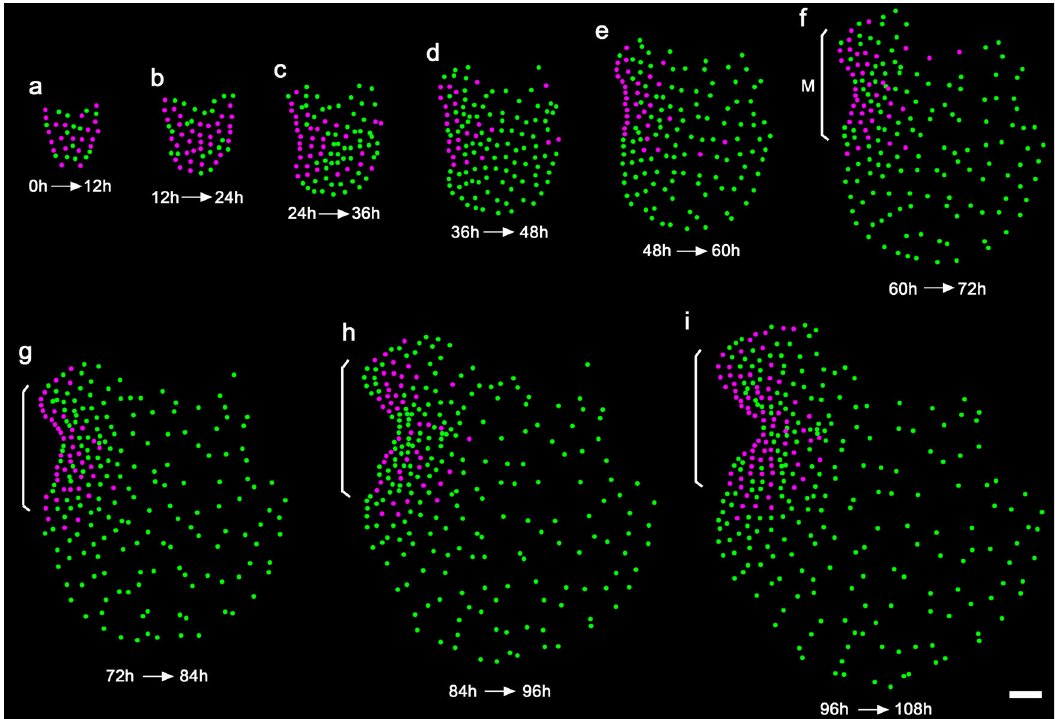
Fig. 4 Spatial and temporal dynamics of cell division in the Ceratopteris gametophyte. a – i Each colored dot represents the detected individual nucleus of the gametophyte shown in Fig. 2. Magenta dots represent cells that divided within the indicated frame; green dots represent cells that did not divide within the indicated time frame. The cell division events of the live-imaged sample are shown in the images from the fi rst time points of the indicated intervals (every 12 h). The brackets indicate the multicellular meristem (M) in the gametophyte. Scale bar: 50 μ m. Three independent samples were analyzed, showing similar patterns during gametophyte development.